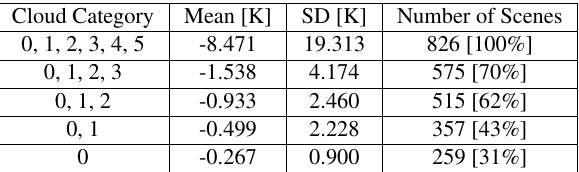
Table 2: Mean and standard deviation for groups of results as scenes with definite and then likely cloud contamination are re- moved.